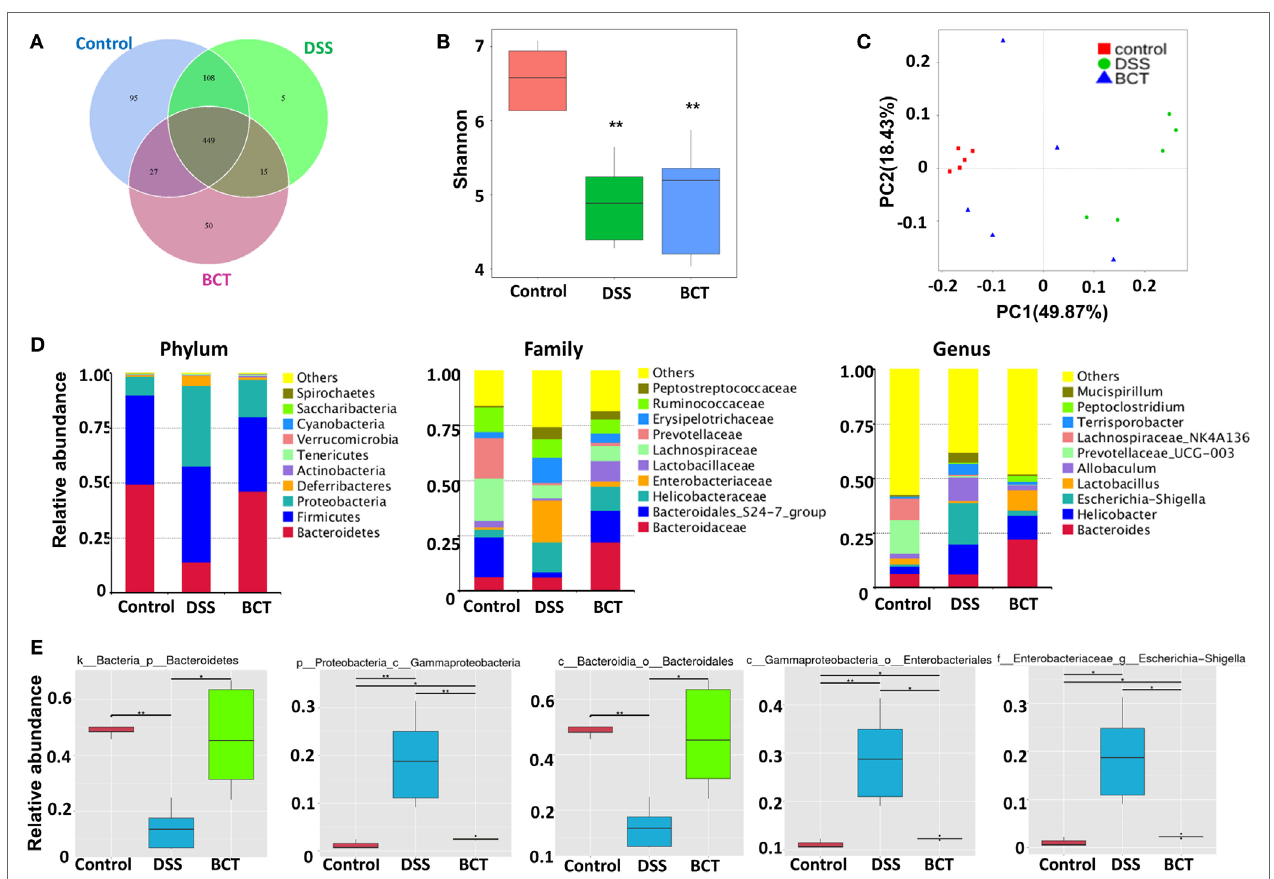
FigUre 5 | BCT modulated intestinal bacterial composition in model mice. (a) Venn diagram of shared and independent bacterial OTUs in different experimental groups ( n = 5). (B) Comparison of the Shannon index of different groups. (c) Principal Coordinate Analysis based on weighted Unifrac distances among different samples. PC1 and PC2 account for 68.30% of the variation. (D) The composition of bacterial composition in different experimental groups at Phylum, Family, and Genus levels. (e) The specific bacterial groups that are significantly manipulated by BCT. The MetaStat method was used to identify the significantly reduced or elevated microbial groups by DSS treatment and was reversed by BCT. k, kingdom; p, phylum; c, class; o, order; f, family; g, genus; All values are mean ±